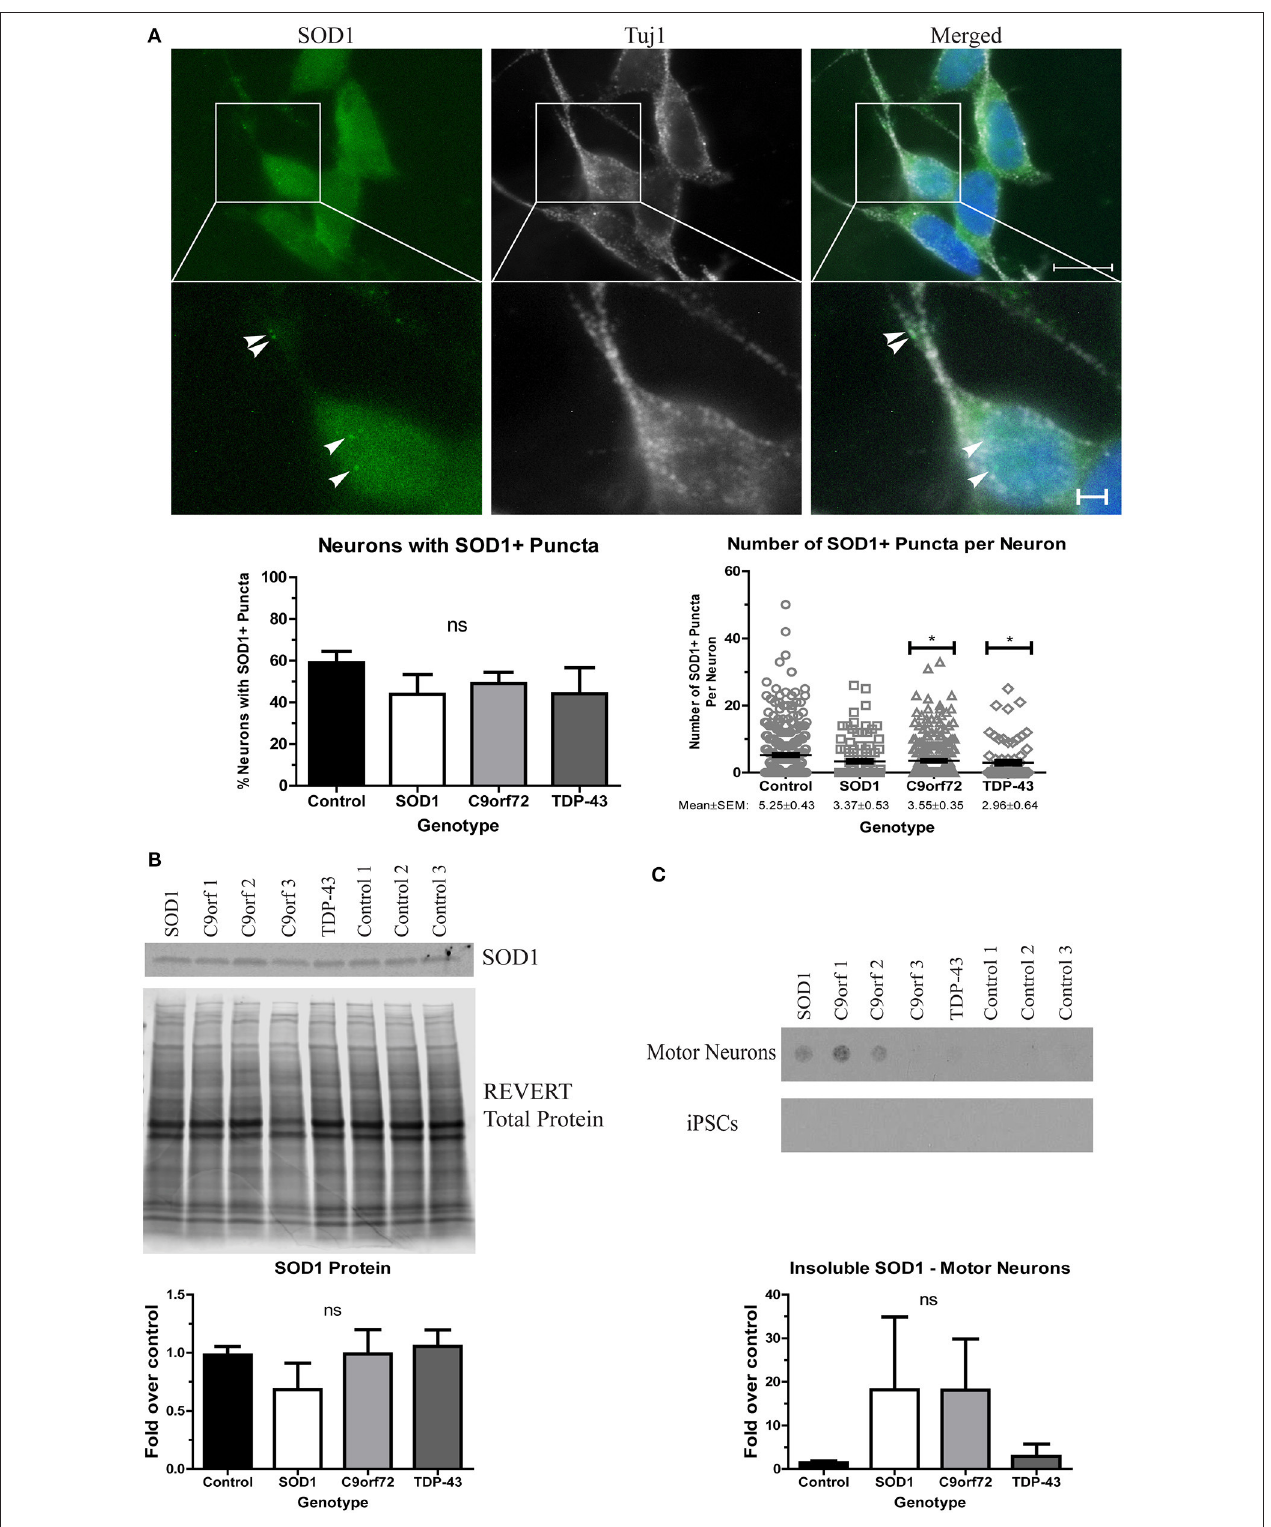
FIGURE 2 | Altered solubility of SOD1 in SOD1 and C9orf72 motor neurons. (A) Representative immunocytochemistry images of Hoechst nuclear stain (blue), SOD1 (green), and Tuj1 (white) at 4 weeks of differentiation shows no significant difference in the number of neurons with SOD1 + puncta in ALS motor neurons compared